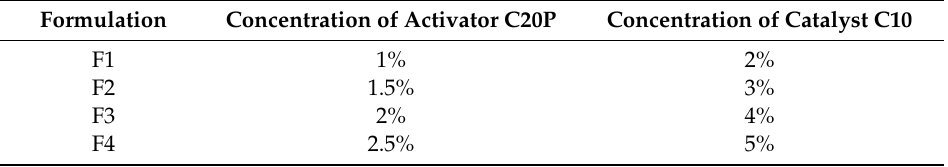
Table 1. Formulations with different concentration of activator and catalyst (percentage by weight).